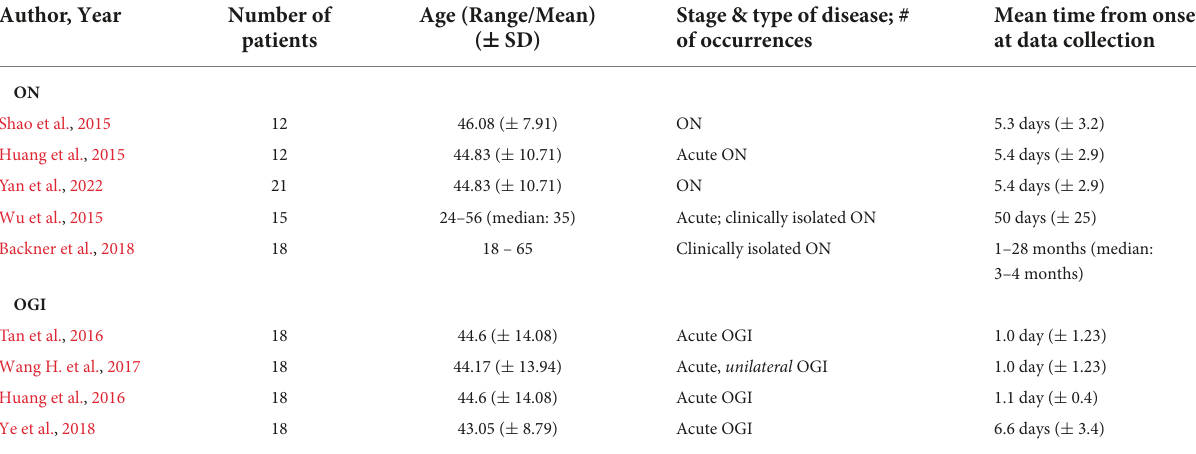
TABLE 1 Patient demographic and disease information from ON and (TON-like) OGI studies reviewed in this paper. Studies are listed in increasing order of average onset duration in patient population at the time of data collection. Unless stated, all studies included patients without